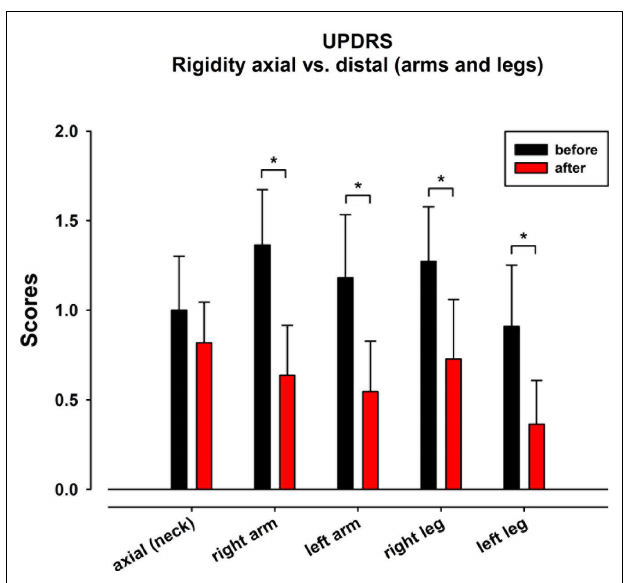
FIGURE 2 | Unified Parkinson disease rating scale III item “rigidity”: axial vs. distal (arms and legs) rigidity. Before (black) and after (red) the dance